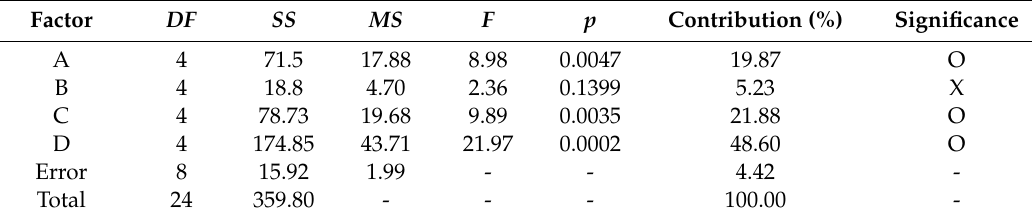
Table 7. Results of ANOVA for PF index.